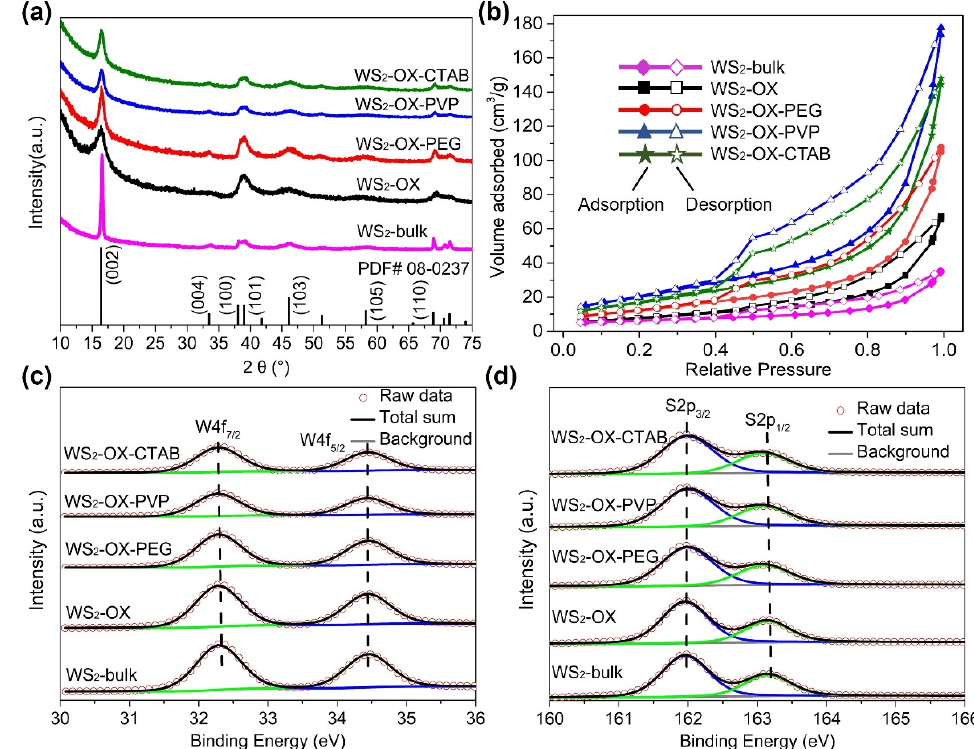
Figure 1. ( a ) XRD patterns of WS 2 -bulk, WS 2 -OX, WS 2 -OX-PEG, WS 2 -OX-PVP, and WS 2 -OX-CTAB. The calculated pattern of WS 2 reference (JCPDS No. 08-0237) is shown at the bottom. ( b ) Nitrogen sorption isotherms BET of WS 2 -bulk, WS 2 -OX, WS 2 -OX-PEG, WS 2 -OX-PVP, and WS 2 -OX-CTAB. ( c , d ) High-resolution X-ray photoelectron spectra of W4f and S2p for WS 2 -bulk, WS 2 -OX, WS 2 -OX-PEG, WS 2 -OX-PVP, and WS 2 -OX-CTAB.